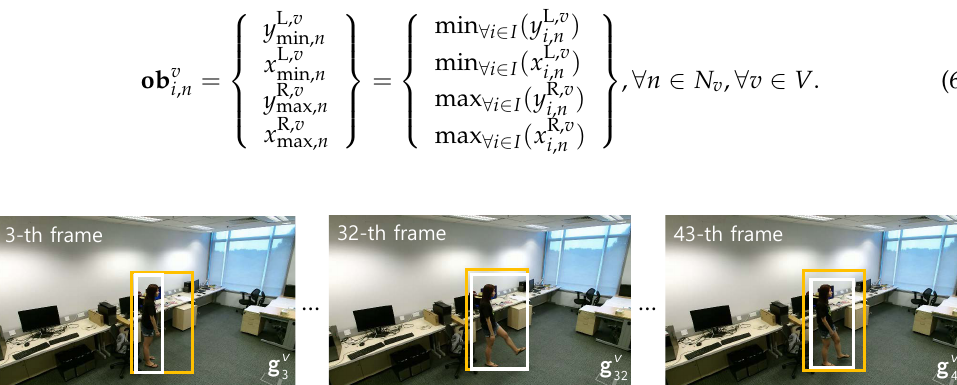
Figure 3. The box-based action regions of the original RGB images within an entire video. The white and yellow boxes extract the basic action region features and the action region features,